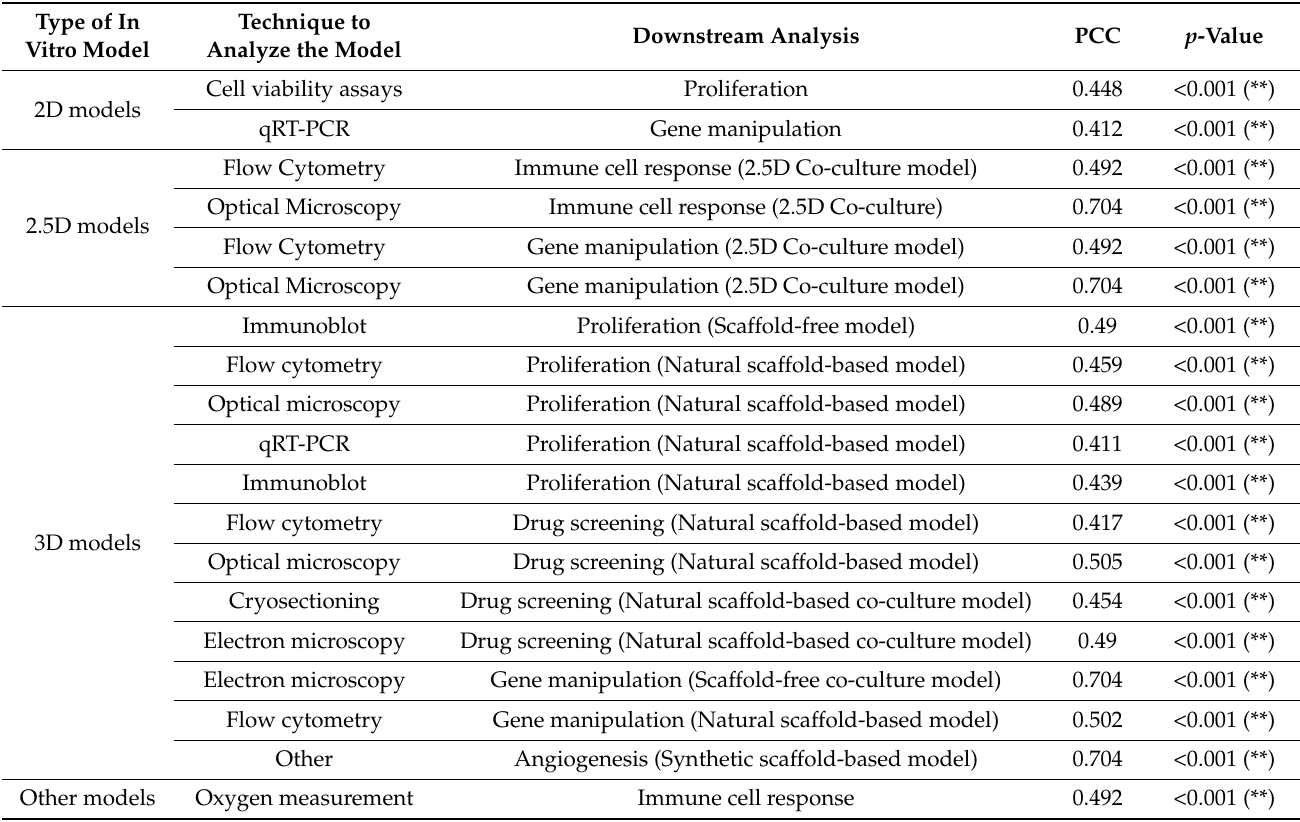
Table 1. Significant correlations between techniques used to analyze in vitro models and downstream analysis (PCC > 0.4). Type of In